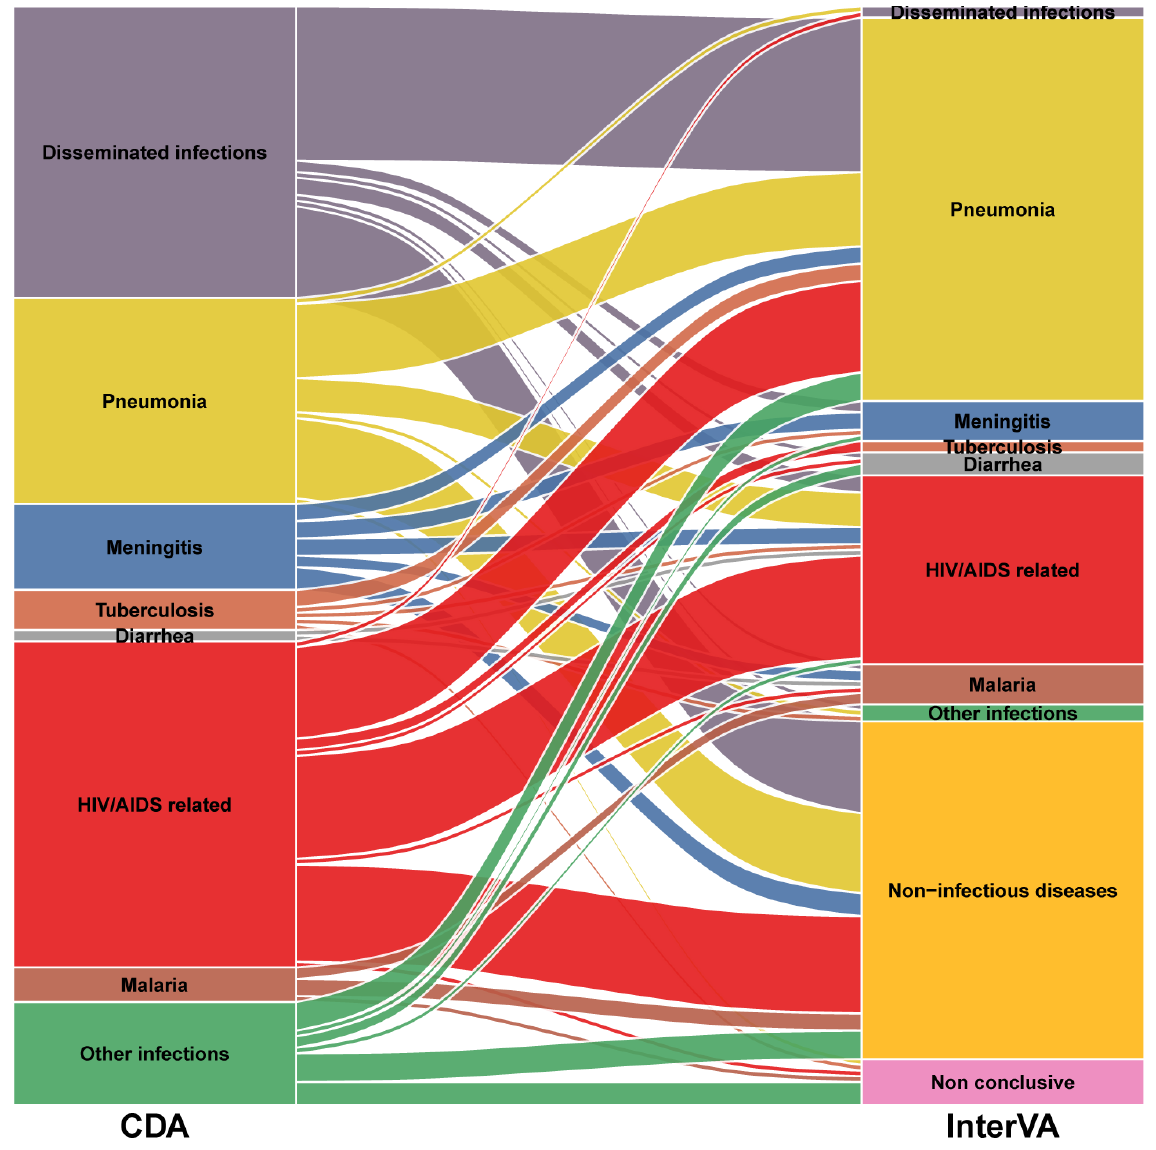
Figure 2. Alluvial diagrams of the differences in the individual cause of death as established by the complete diagnostic autopsy (CDA) and the InterVA (Interpreting Verbal Autopsy) model among patients who died of infectious diseases. The stacked blocks represent the causes of death (CoDs) determined by the CDA (left) and by the InterVA model (right), and their size as proportional to the cause-specific mortality fractions (CSMFs). The branches between blocks represent differences in the composition of the CoDs between the CDA and the InterVA model, being their thickness proportional to the number of cases contained in both blocks connected by the branch. Each CoD is represented by a different color, which is the same in both diagnostic methods. The color of the branches is determined by the cause of actual death (CDA). The concordant cases between the CDA and the InterVA model are represented by branches connected to blocks of the same color. In contrast, misclassification cases are shown as branches connected to blocks of different color. Diseminated infections: bacterial sepsis of the newborn (n=21), puerperal sepsis (n=6), streptococcal sepsis (n=5) and other sepsis (n=19) HIV/AIDS related infections: candidiasis (n=1), congenital viral diseases (n=1), cryptococcosis (n=11), cytomegaloviral disease (n=7), herpes simplex infection (n=1), miliary tuberculosis (n=20), salmonella infection (n=1), pneumocystosis (n=5), respiratory tuberculosis bacteriologically and histologically confirmed (n=2), toxoplasmosis (n=7) and tuberculous meningitis (n=1) Other infections: acute pericarditis (n=2), pyelonephritis (n=2), congenital viral diseases (n=2), chorioamnionitis (n=2), GBS infection (n=2), tetanus (n=1), peritonitis (n=3), rabies (n=3) and zygomycosis (n=1) Non-infectious diseases (by the InterVA model): congenital malformations (n=1), intrapartum complication (n=2), eclampsia (n=12), obstetric haemorrhage (n=10), non-obstetric diseases (n=5)and other diseases